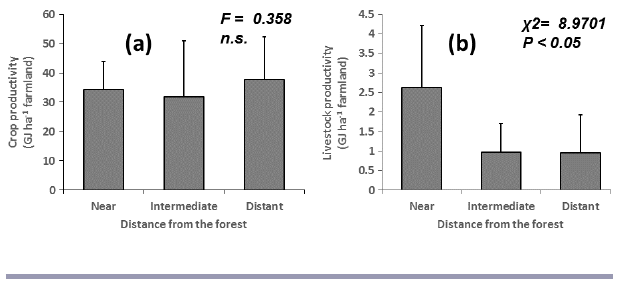
Fig. 5 . (a) Mean crop productivity, and (b) mean livestock productivity of farms in the three zones of the study area (near, intermediate, and distant to Munesa Forest). Bars represent standard deviations. F and P values are given for the Fischer test (comparison of means), and χ 2 and P values are given for the Kruskal–Wallis tests (comparison of medians).